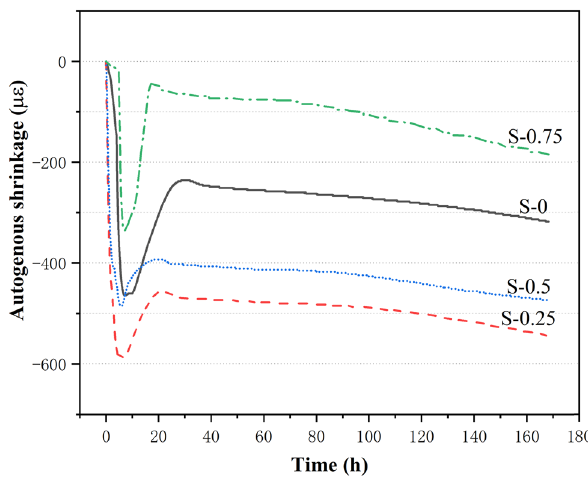
Figure 3: Compressive strength of cement paste added with dif - ferent dosages of nano - C – S –